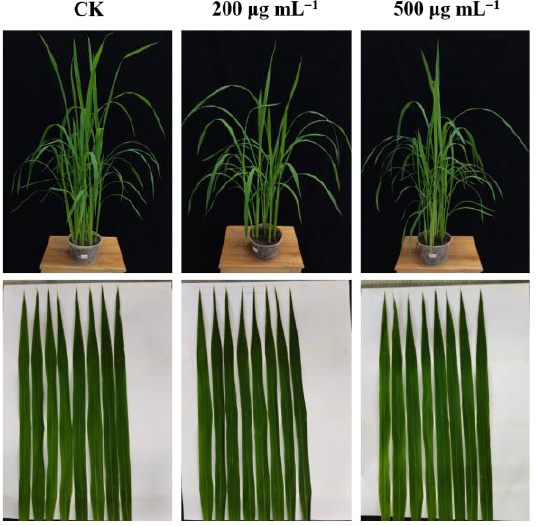
Figure 9. The phytotoxicity of C 4 at 200 and 500 µg mL − 1 on rice plants in a controllable greenhouse.